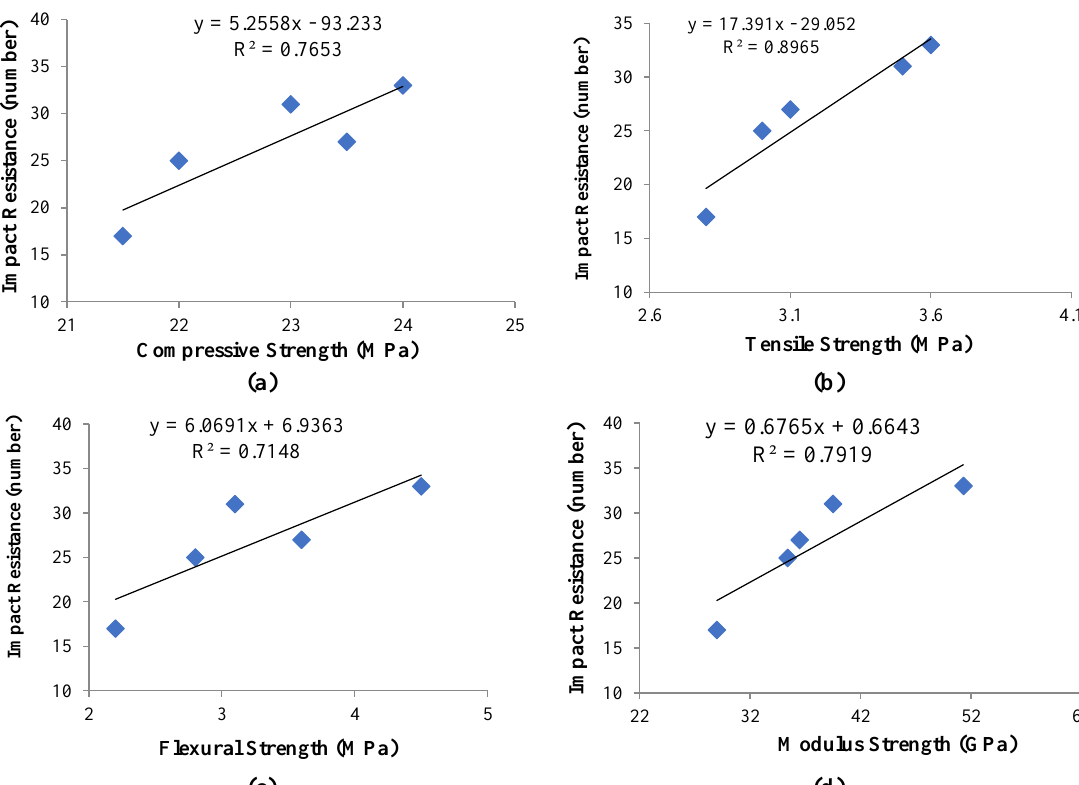
Fig. 5. Relations between: a) Compressive strength; b) Tensile strength; c) Flexural strength; and d)